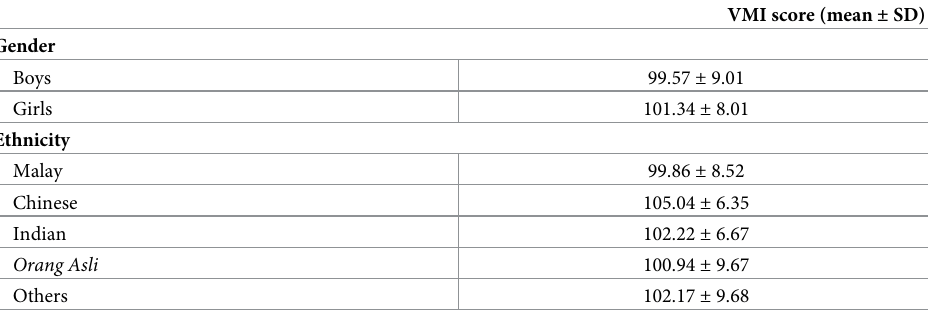
Table 2. VMI mean standard score based on participants’ gender and ethnic group.